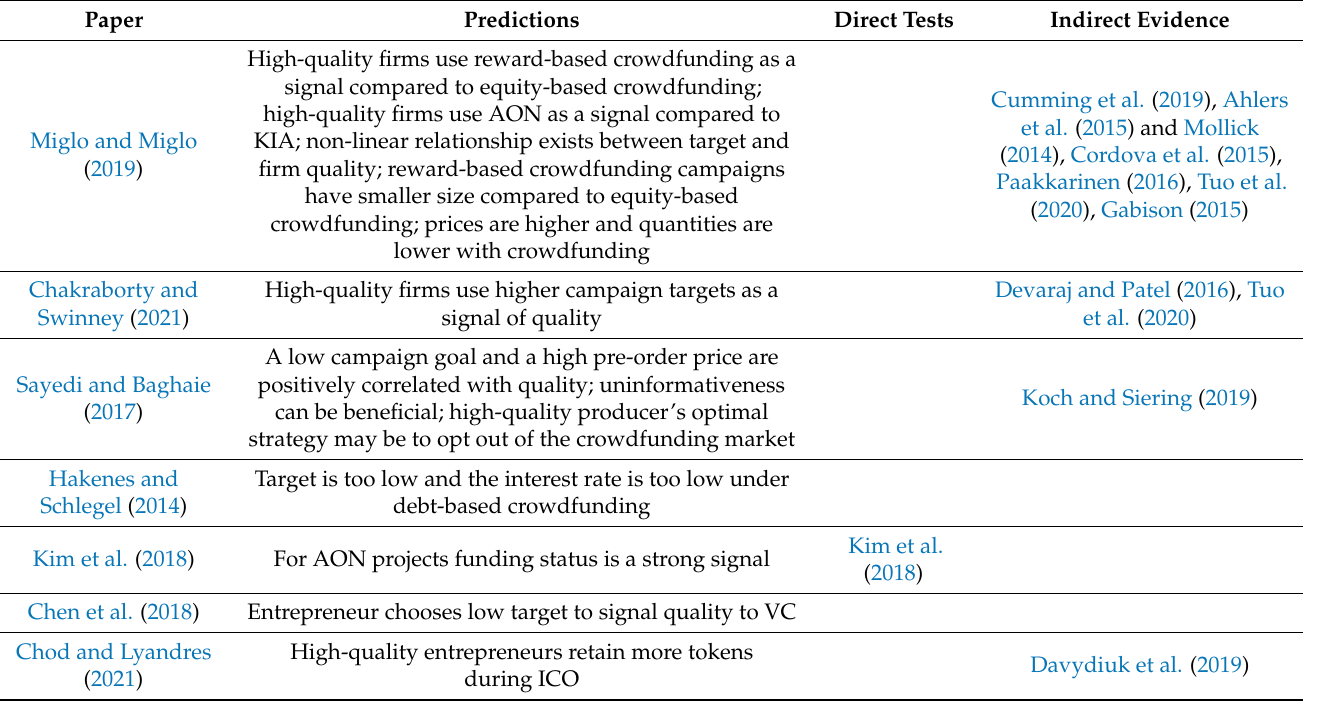
Table 2. Signalling theories of crowdfunding and token